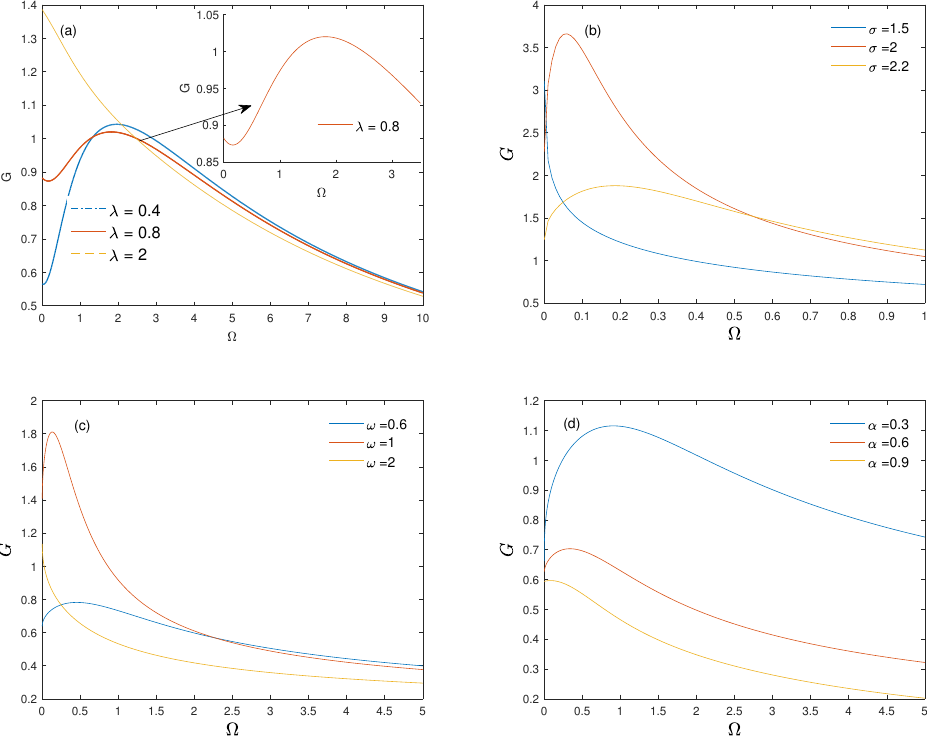
Figure 2. The output gain G as function of Ω under different values of system parameters, respectively. The values of the parameters are: ( a ) σ = 1, α = 0.9, and ω = 1, ( b ) λ = 1, α = 0.4, and ω = 1.3, ( c ) σ = 1.8, α = 0.5, and λ = 0.8, and ( d ) λ = 1.8, σ = 0.9, and ω =